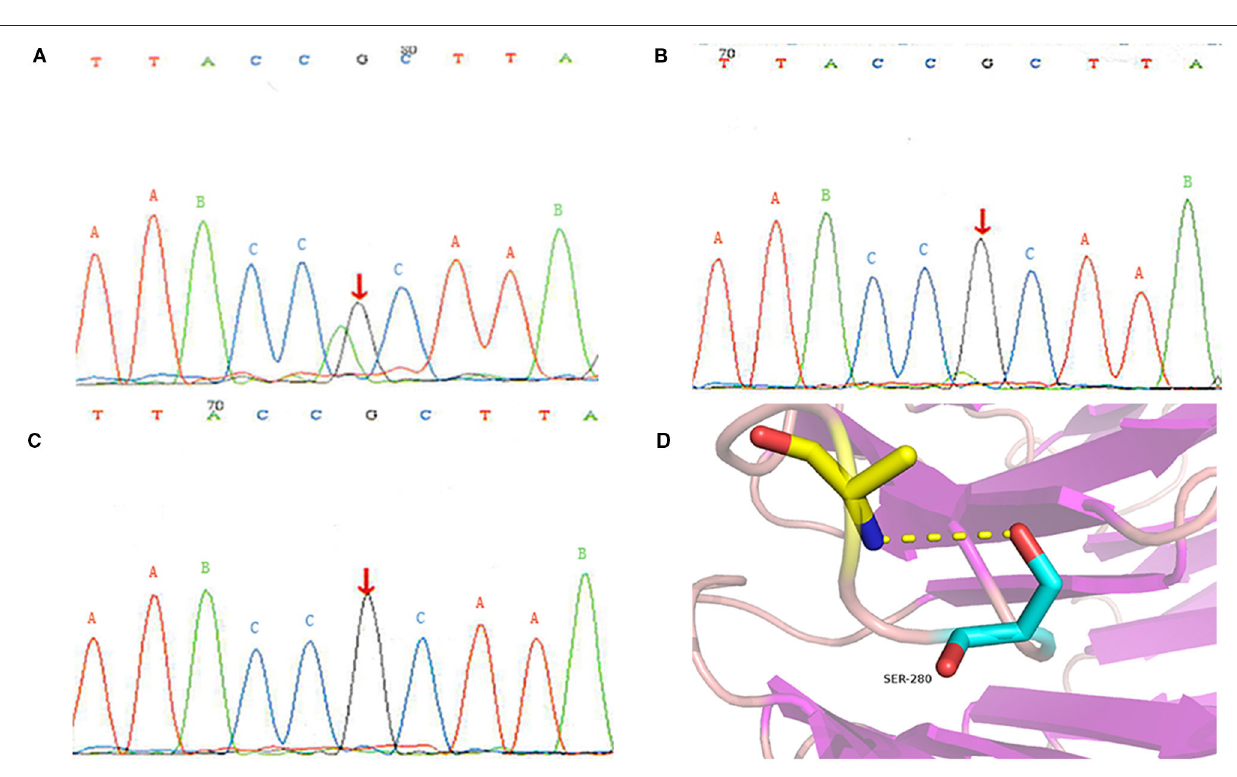
Frontiers in Pediatrics | www.frontiersin.org